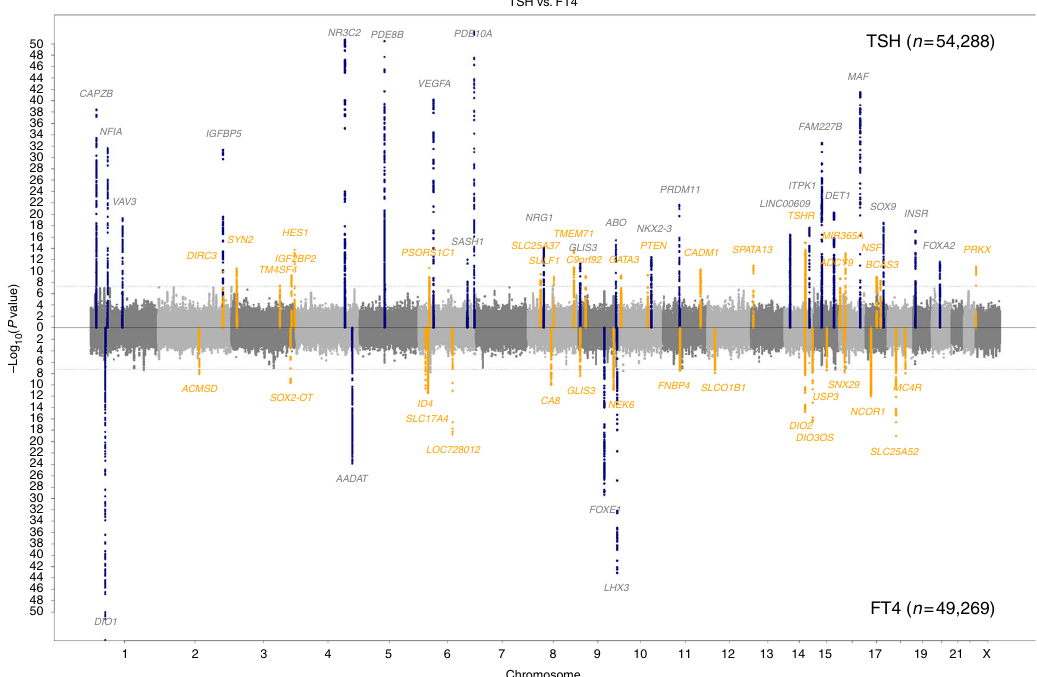
Fig. 1 Manhattan plots for GWAS meta-analyses of thyroid function. Manhattan plots of the GWAS meta-analysis results for TSH and FT4 contrasted with each other. SNPs are plotted on the x axis according to their position on each chromosome with − log 10 ( p -value) of the association test on the y axis. The upper solid horizontal line indicates the threshold for genome-wide signi fi cance, i.e., 5 × 10 − 8 . Genomic loci previously known to contain trait-associated variants are colored in blue, new loci in